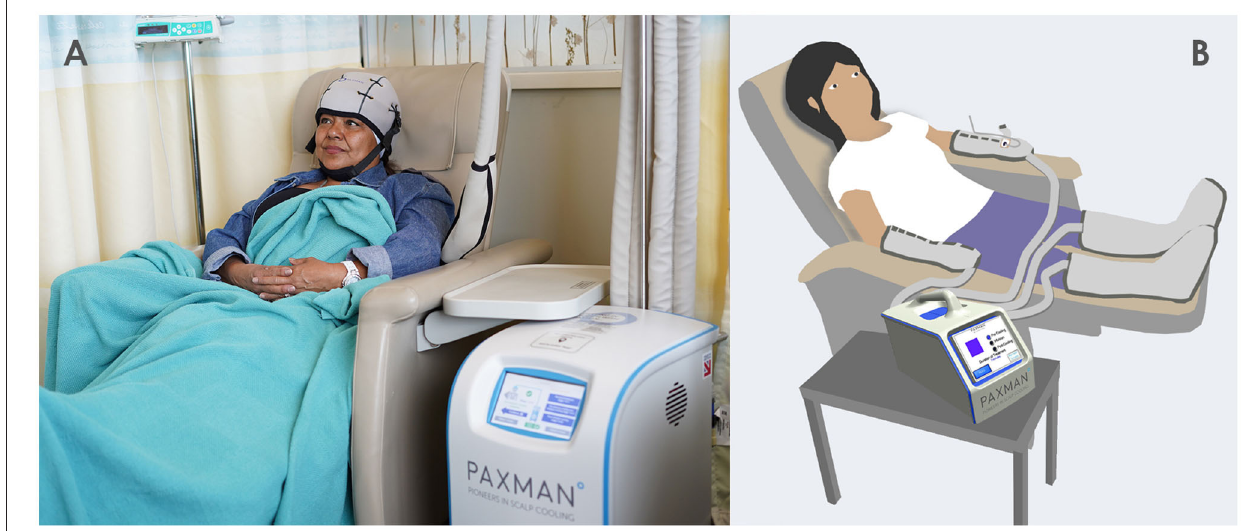
FIGURE 1 | Paxman Scalp Cooling System (A) , proposed limb cryocompression system & cooling wraps (B)